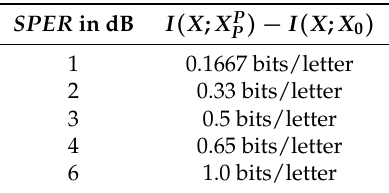
Table 3. Change in mutual information from Equation (17) for various pitch predictors and corresponding